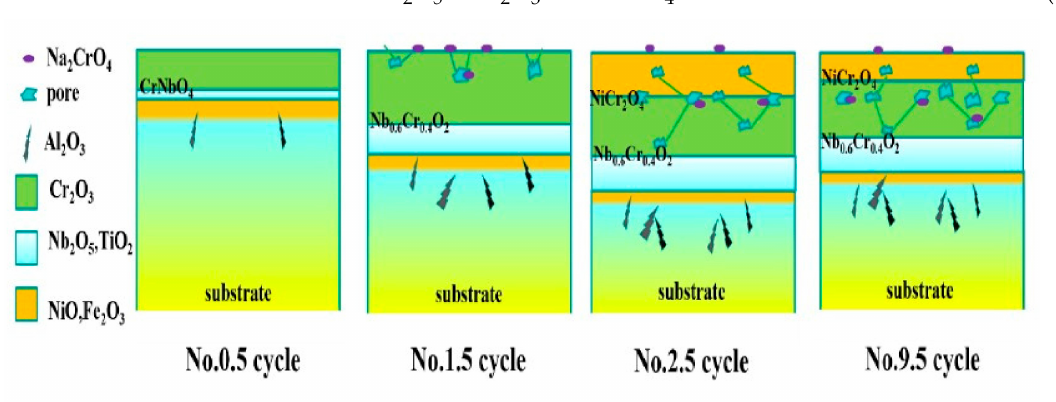
Figure 10. Schematic of GH4169 during the corrosion process under alternating oxidation at 900 ◦ C and solution